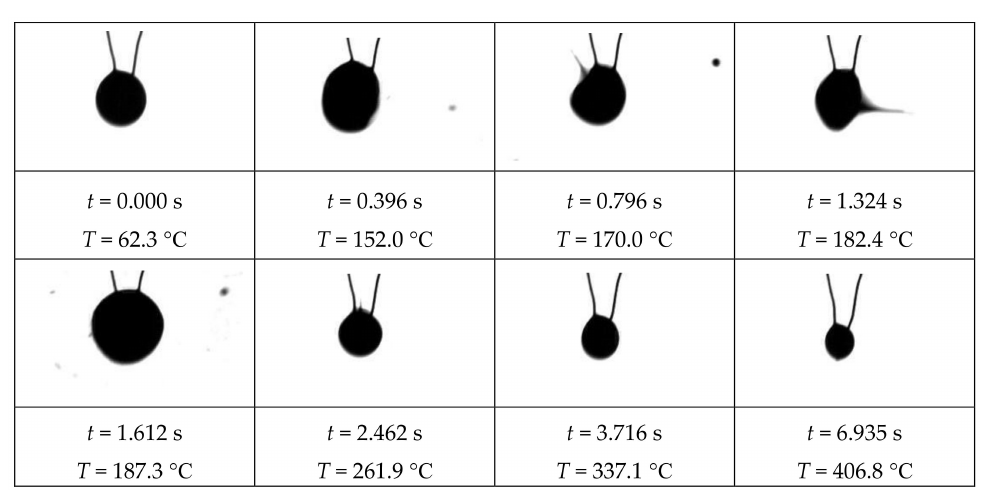
Figure 6. The images of microexplosion characteristics and shape change with heating time of an emulsified droplet with initial diameter d 0 = 1.05 mm at 400 ◦ C environment. T represents the instantaneous temperature at the time of obtaining each image.